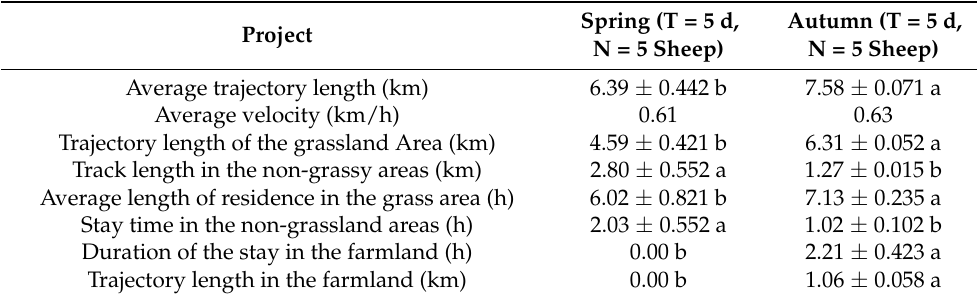
Table 1. Quantitative characteristics of the displacement trajectories of the grazing sheep in the spring and